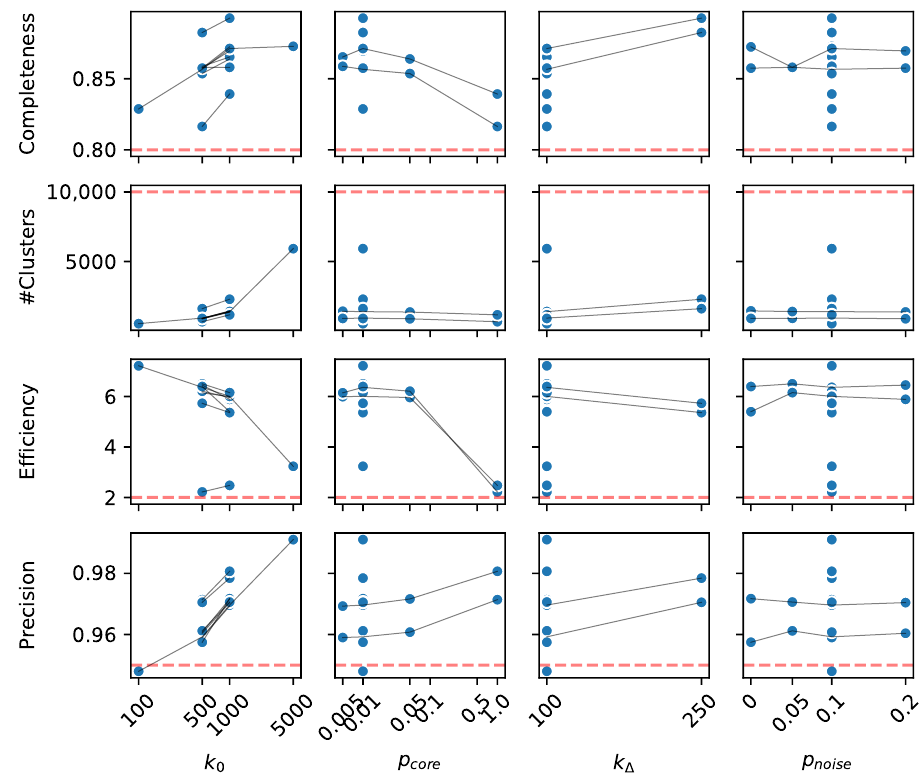
Figure A9. Partially labeled k -means: Dependency of completeness, number of resulting clusters, efficiency and sorting precision on noise fraction p noise , cluster count increment k ∆ , initial number of clusters k 0 and and core fraction p core